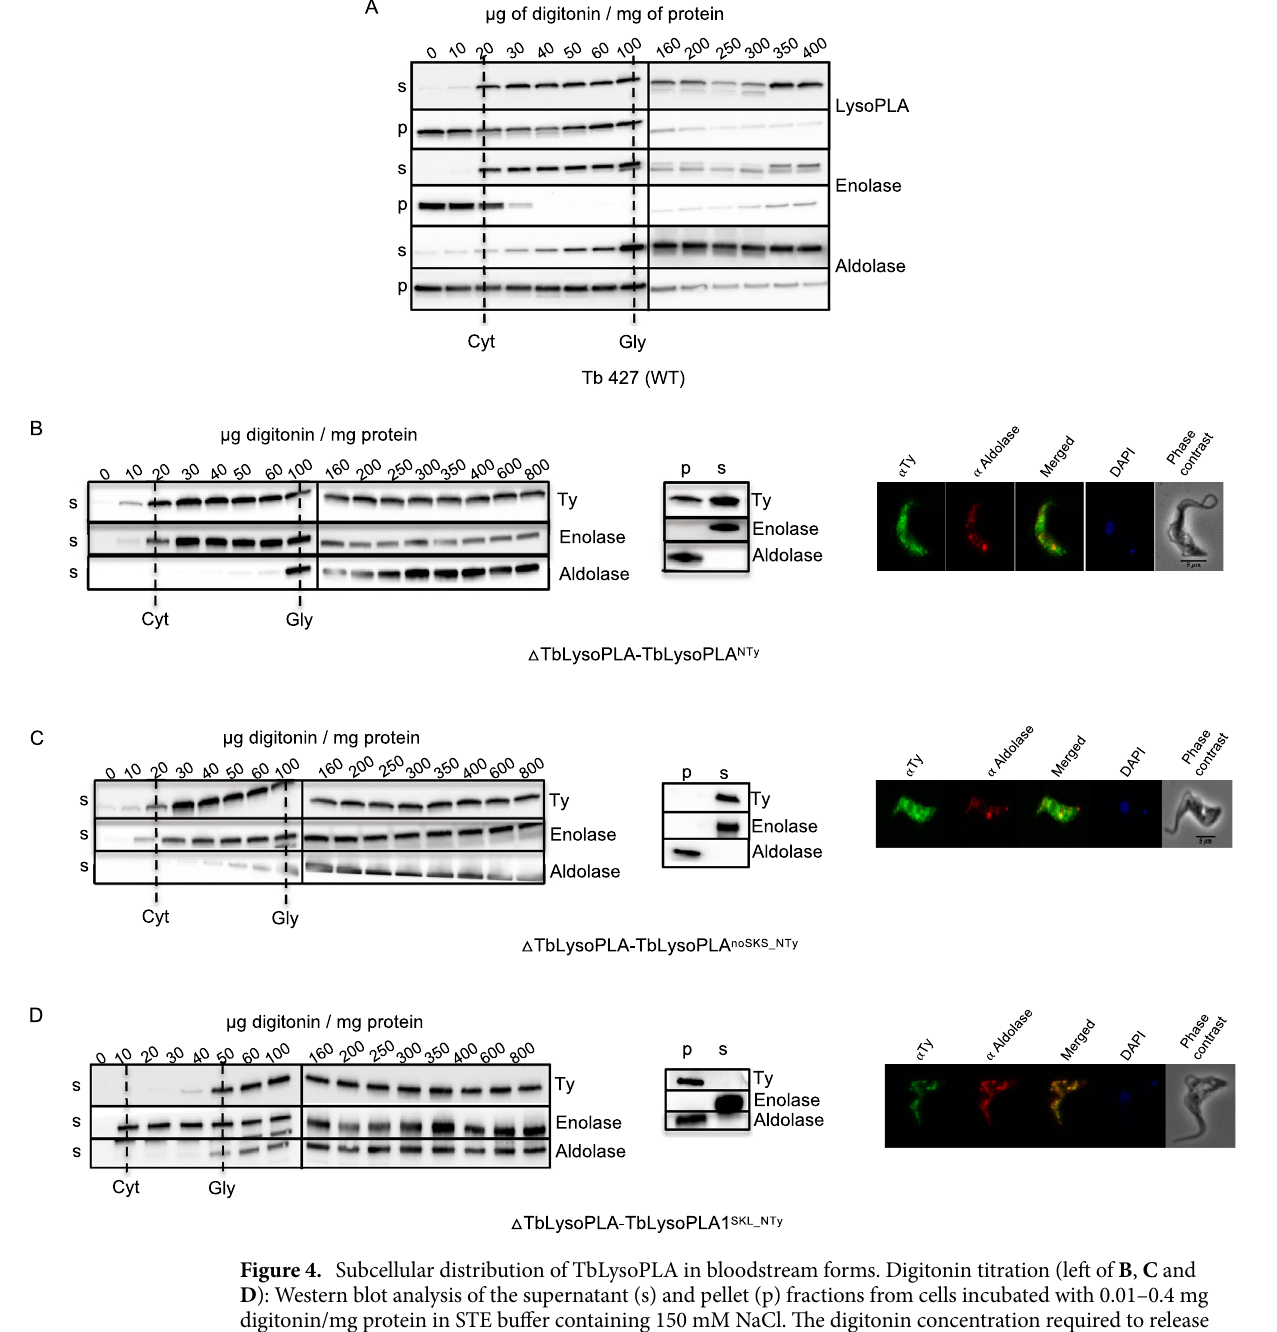
glycosomal localisation is due to a unique non-canonical PTS1 signal (SKS). In addition, the enzyme is found in the material excreted by the parasites and antibodies against this protein were detected in mice experimentally infected with T.b gambiense .